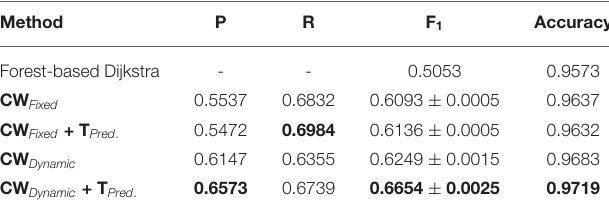
TABLE 5 | Results on VEVIO dataset (Mosaics).